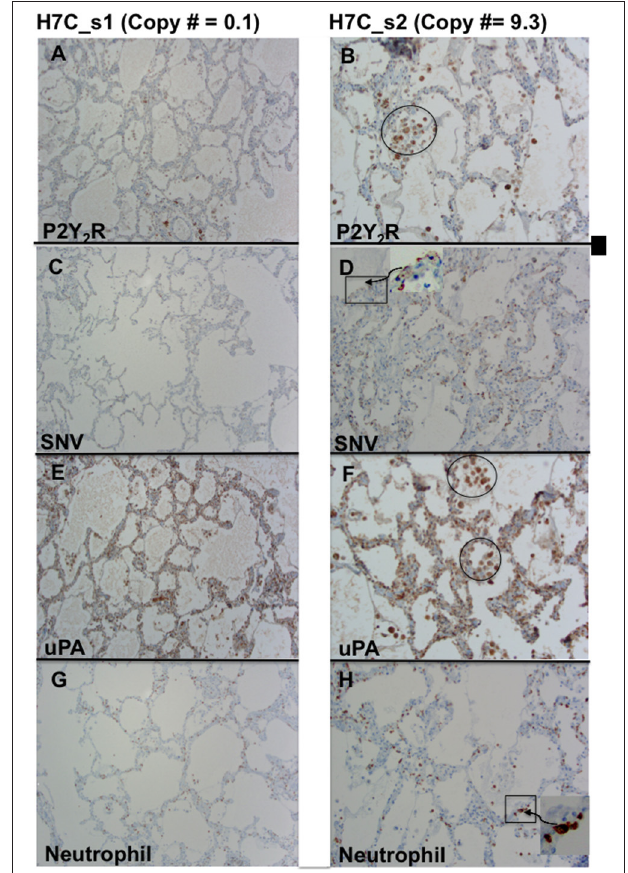
FIGURE 6 | Comparison of serial sections from two different lung segments expressing low (s1) and high levels of P2Y 2 R (s2) from HCPS patient (case H7 Block C). (A) Weak staining for P2Y 2 R segment 1 corresponds to low P2Y 2 R copy numbers (0.1 TaqMan). (B) Relatively high P2Y 2 R copy numbers (9.3 TaqMan) is associated with a robust positive staining for P2Y 2 R in macrophages and endothelial cell-proximal type II pneumocytes. (C) Weak staining for SNV in segment 1. (D) Stronger positive staining for SNV in type II- pneumocytes and endothelial cells. (E,F) Comparative staining for uPA staining in s1 and s2 segments stronger staining in s2 associated with higher macrophage deposits (circle). (G,H) Relative staining for neutrophil elastase